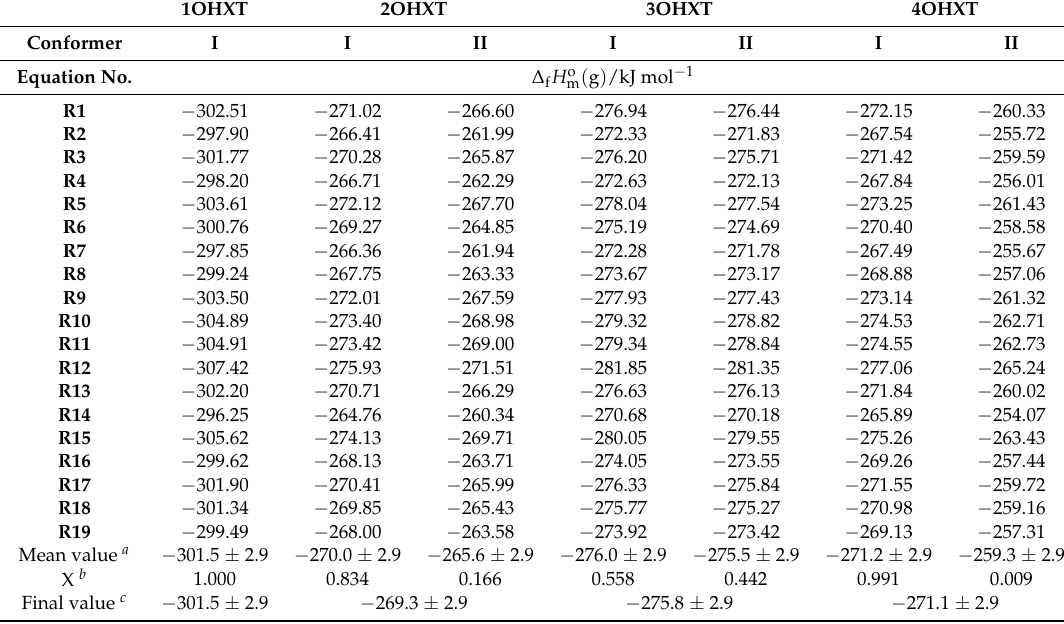
Table 5. Estimated standard gas-phase molar enthalpies of formation, ∆ f H o m ( g ) , at T = 298.15 K for the monohydroxyxanthone conformers derived from hypothetical gas-phase reactions. 1OHXT 2OHXT 3OHXT 4OHXT